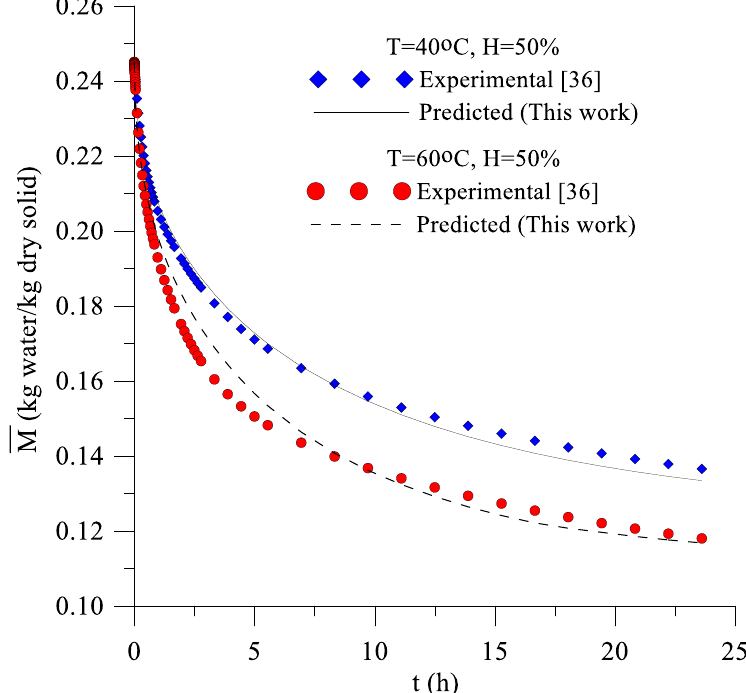
Figure 4. Predicted and experimental average moisture contents of lentils during drying at 40 °C and 60 °C and a relative humidity of 50%.